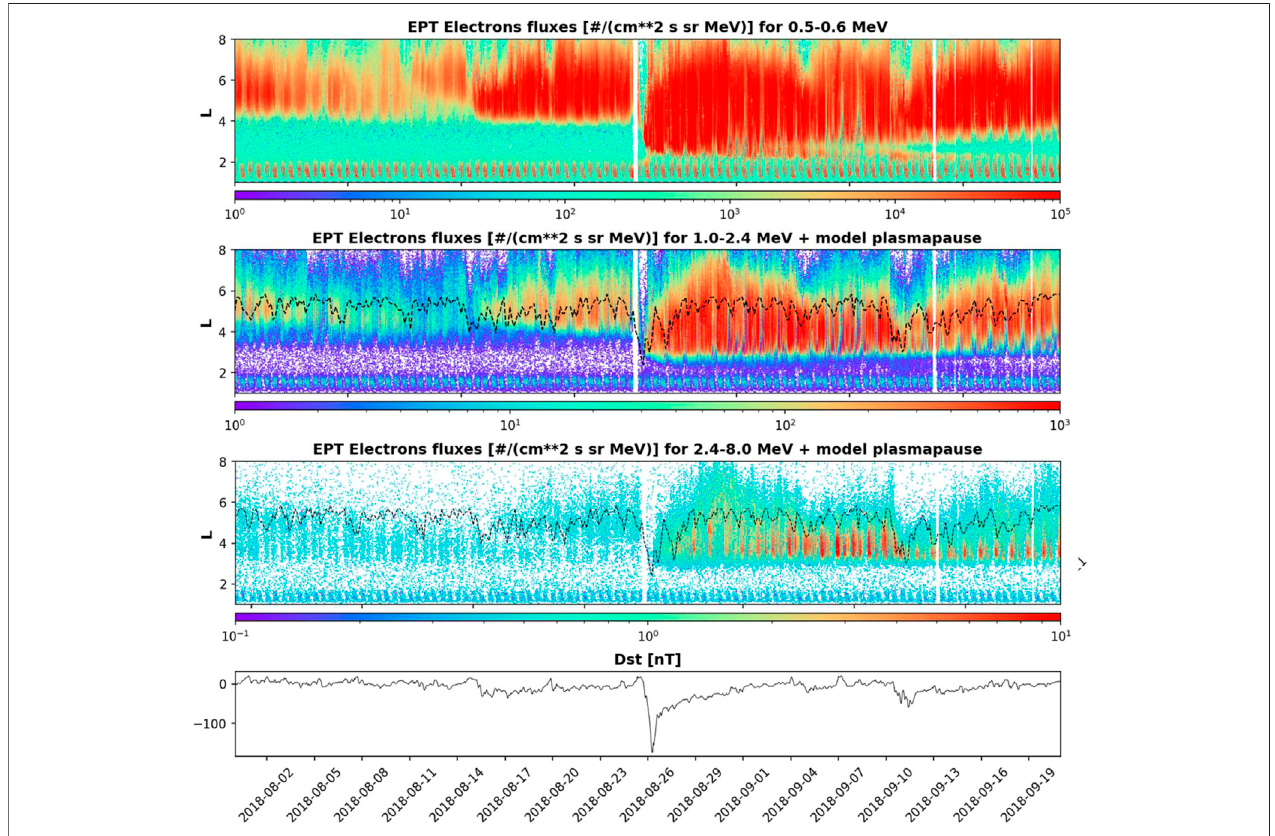
FIGURE 12 | Electron fl ux measured by PROBA-V/EPT at 500 – 600 keV from 1 August to September 20, 2018. Second panel: Electron fl ux measured by PROBA-V/EPTat1 – 2.4 MeVfrom1AugusttoSeptember20,2018.TheblackdottedlinecorrespondstotheplasmapauseobtainedfromtheSPMmodel. Thirdpanel: Same as second panel but for 2.4 – 8 MeV. Bottom panel: Observed Dst